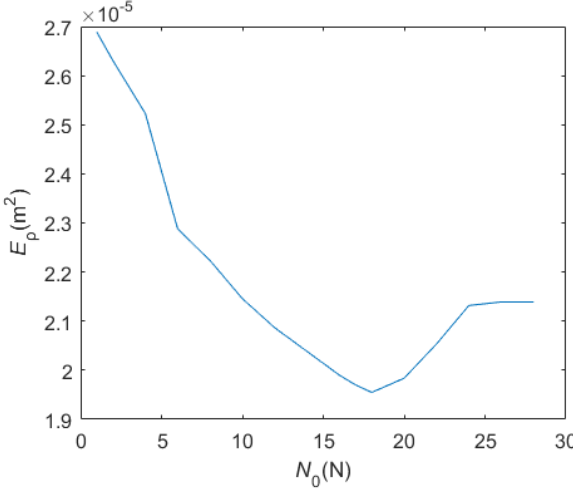
Figure 20. The pre-load versus Normalized energy density curve.